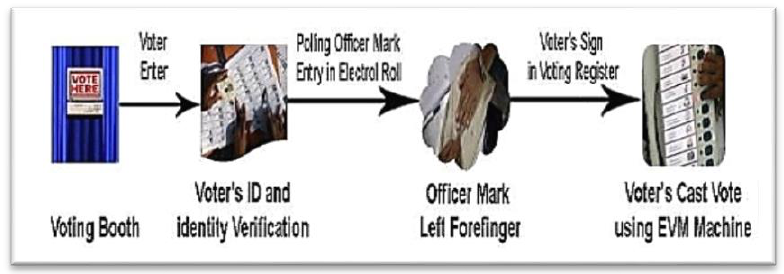
Figure 1 . Existing voting process